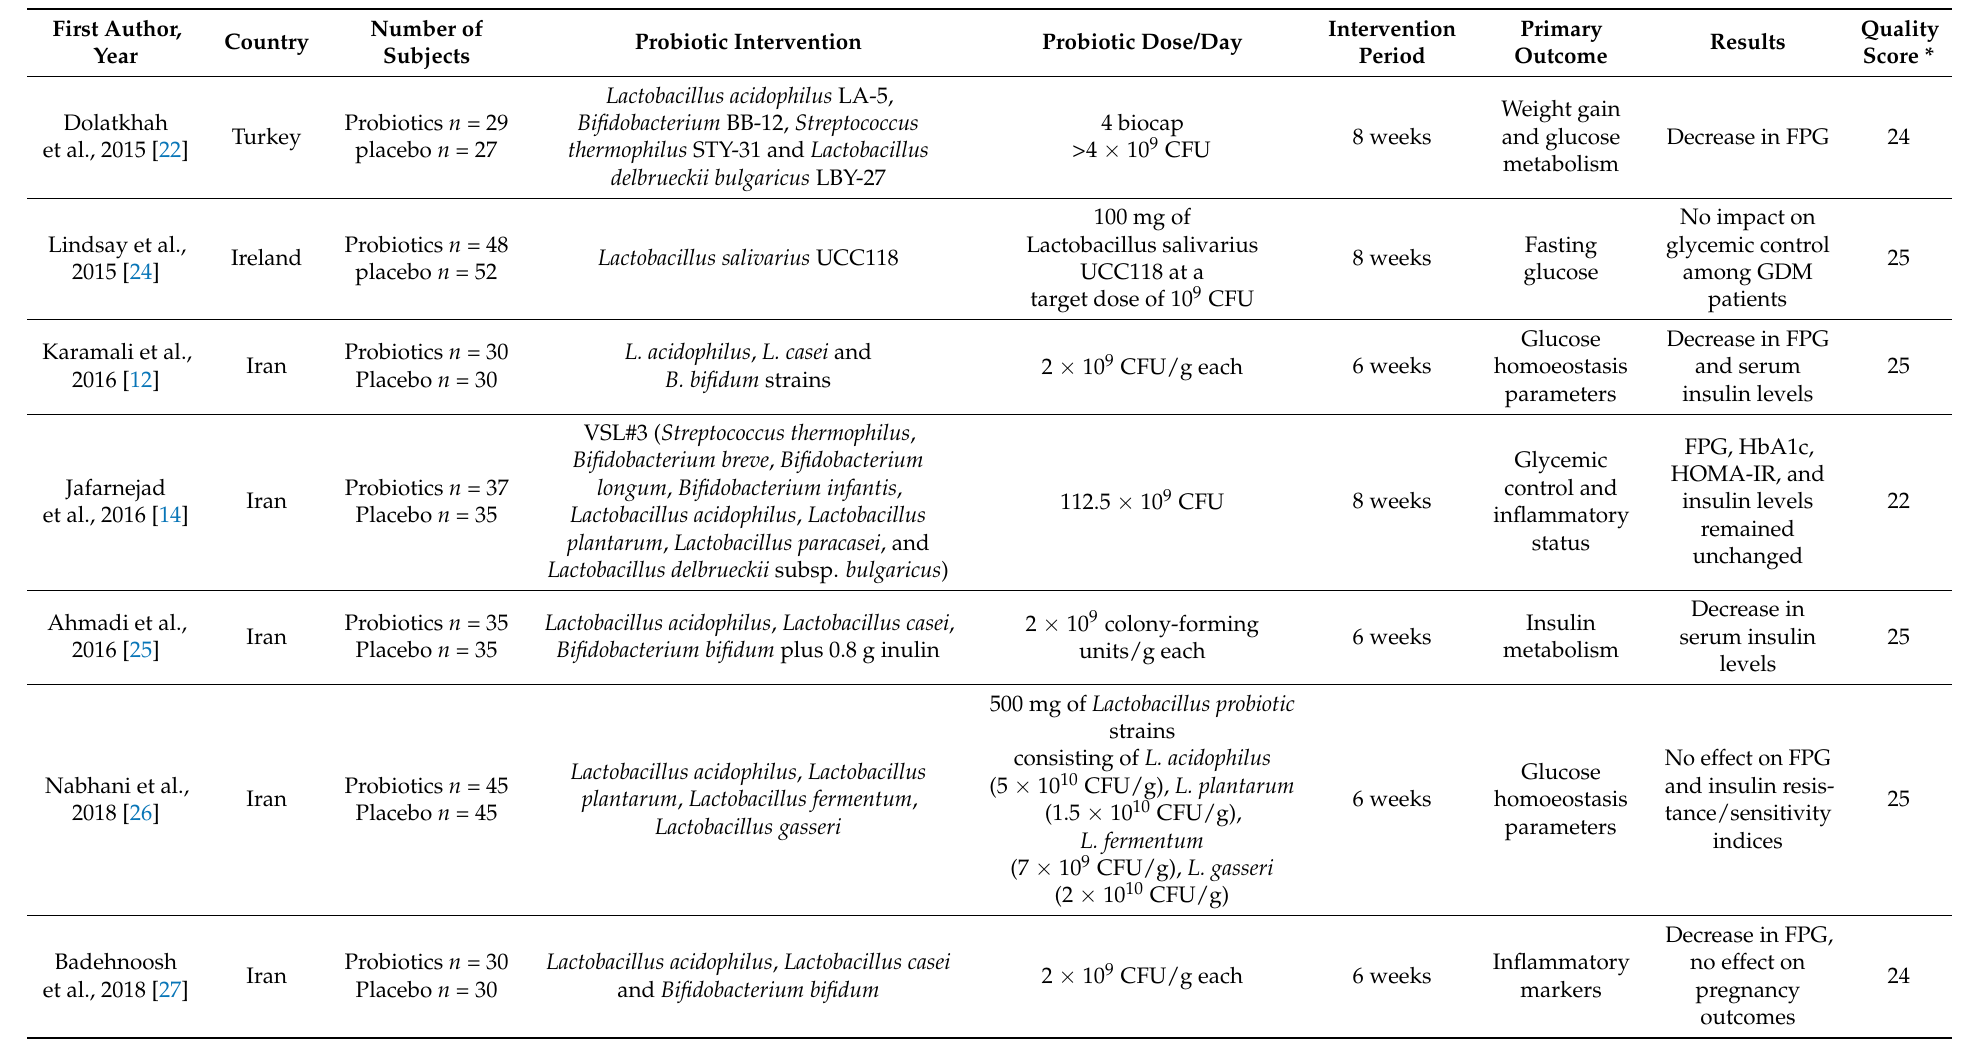
Table 1. Summary of included